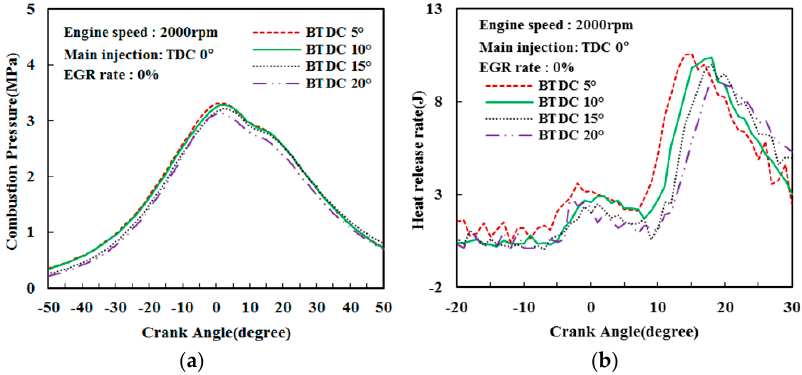
Figure 12. Combustion pressure ( a ) and heat release rate ( b ) of BD20 at various pilot injection timings. TDC: top dead centre; BTDC: before top dead centre